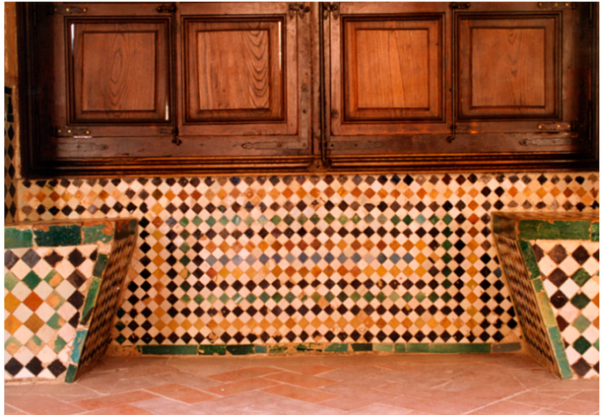
Figure 18. Alicatado panels beneath the mullioned window in the Cuarto Dorado in 1994. © Archivo del Patronato de la Alhambra y Generalife, Photograph Collection,